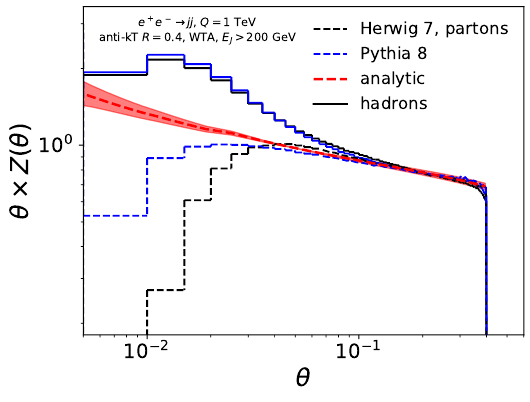
Figure 2 . The energy distribution in a jet, see eq. (3.1), is a power law as function of the angle (cid:18) with the winner-take-all axis. Our analytic predictions agree with those obtained from Pythia and Herwig , except for very small angles where nonperturbative e(cid:11)ects are